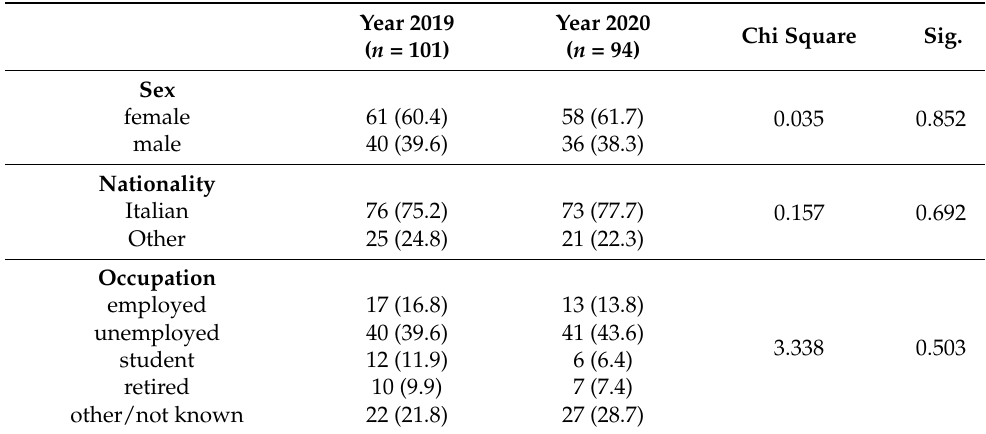
Table 1. Demographic characteristics of the study sample. Values presented in parentheses are per cent, unless otherwise